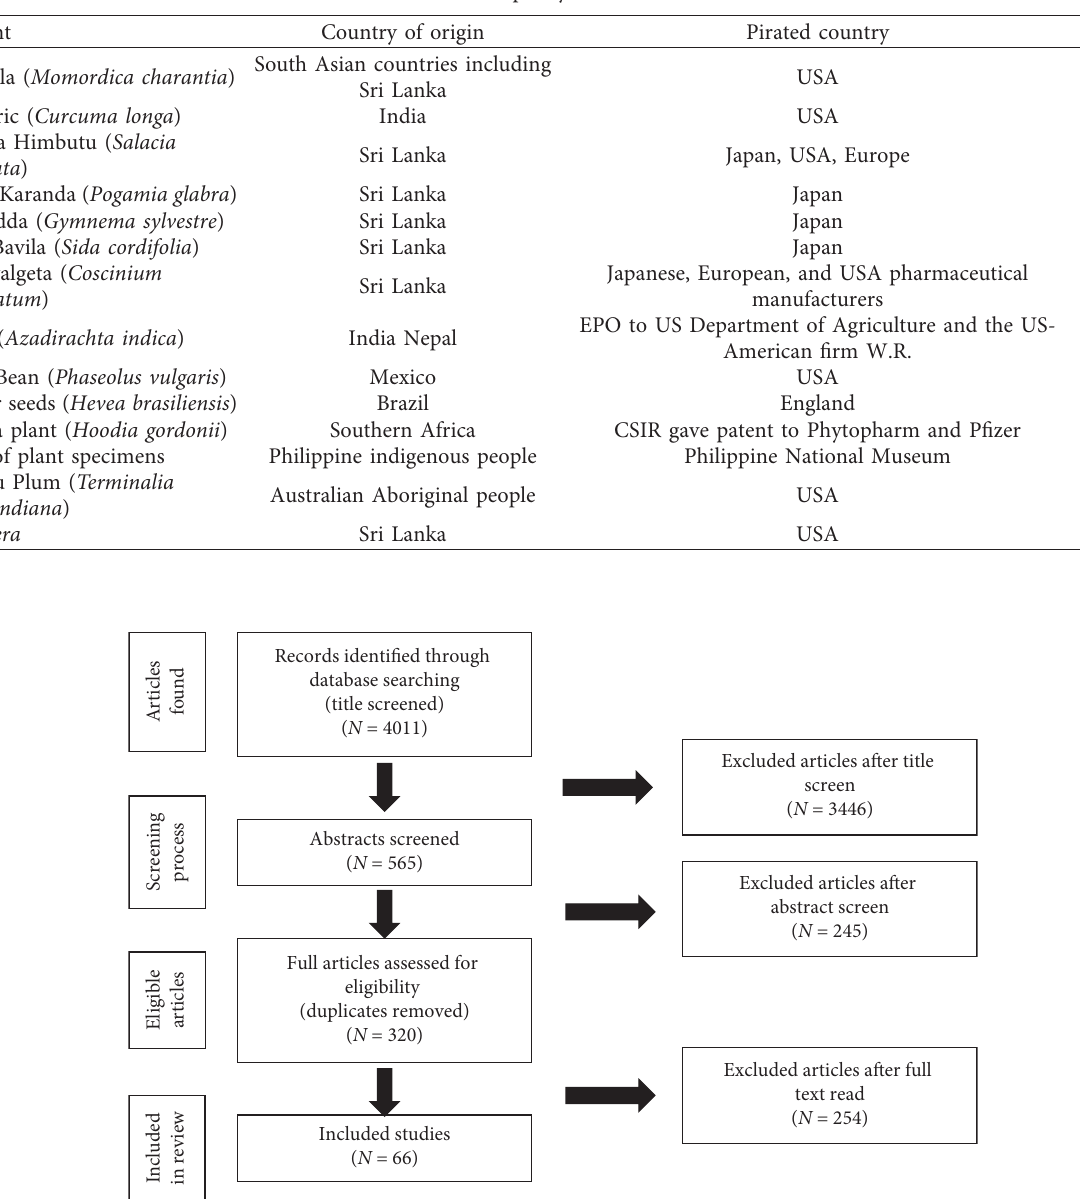
Figure 1: Method of article screening.